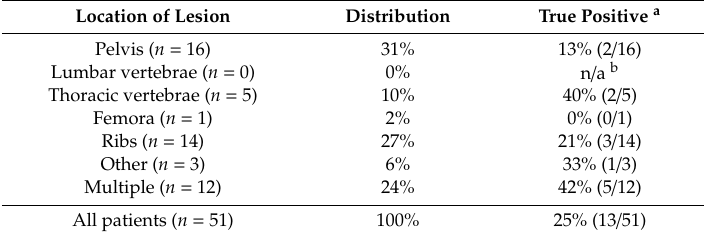
Table 2. Anatomical locations of the equivocal lesions on 18 F-NaF PET / CT in 51 patients.